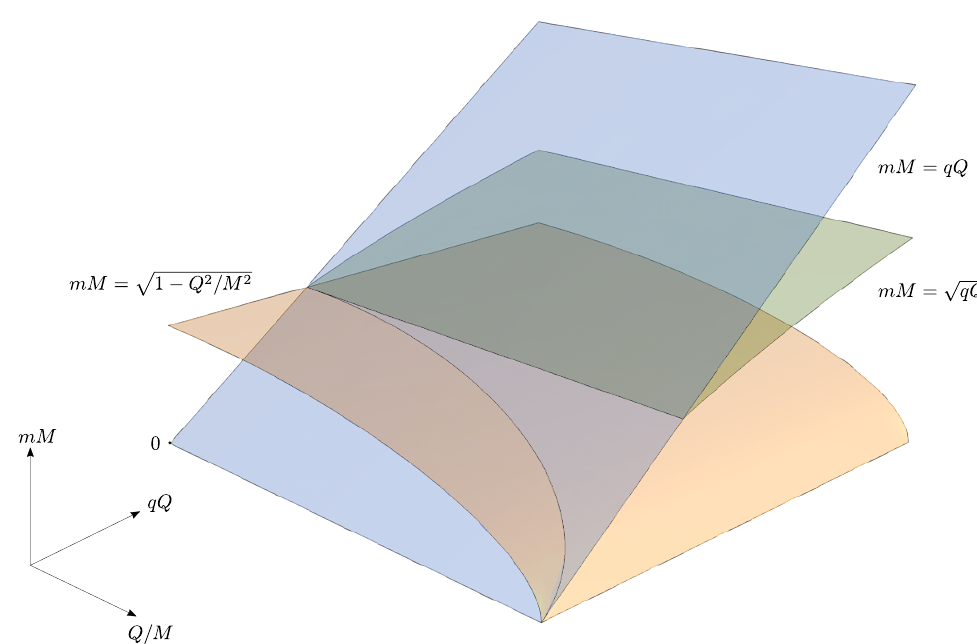
Figure 1 . A plot of the regions in parameter space in which the two emission processes are important. On the three axes are plotted the mass of the emitted particle, the charge of the emitted particle, and the mass-to-charge ratio of the black hole. Beneath the orange surface, Hawking radiation is appreciable. Beneath the blue plane, Schwinger pair production is possible. Beneath the green surface, Schwinger pair production is appreciable. Here Q=M ranges between zero and one, whilst the other two quantities range between zero and